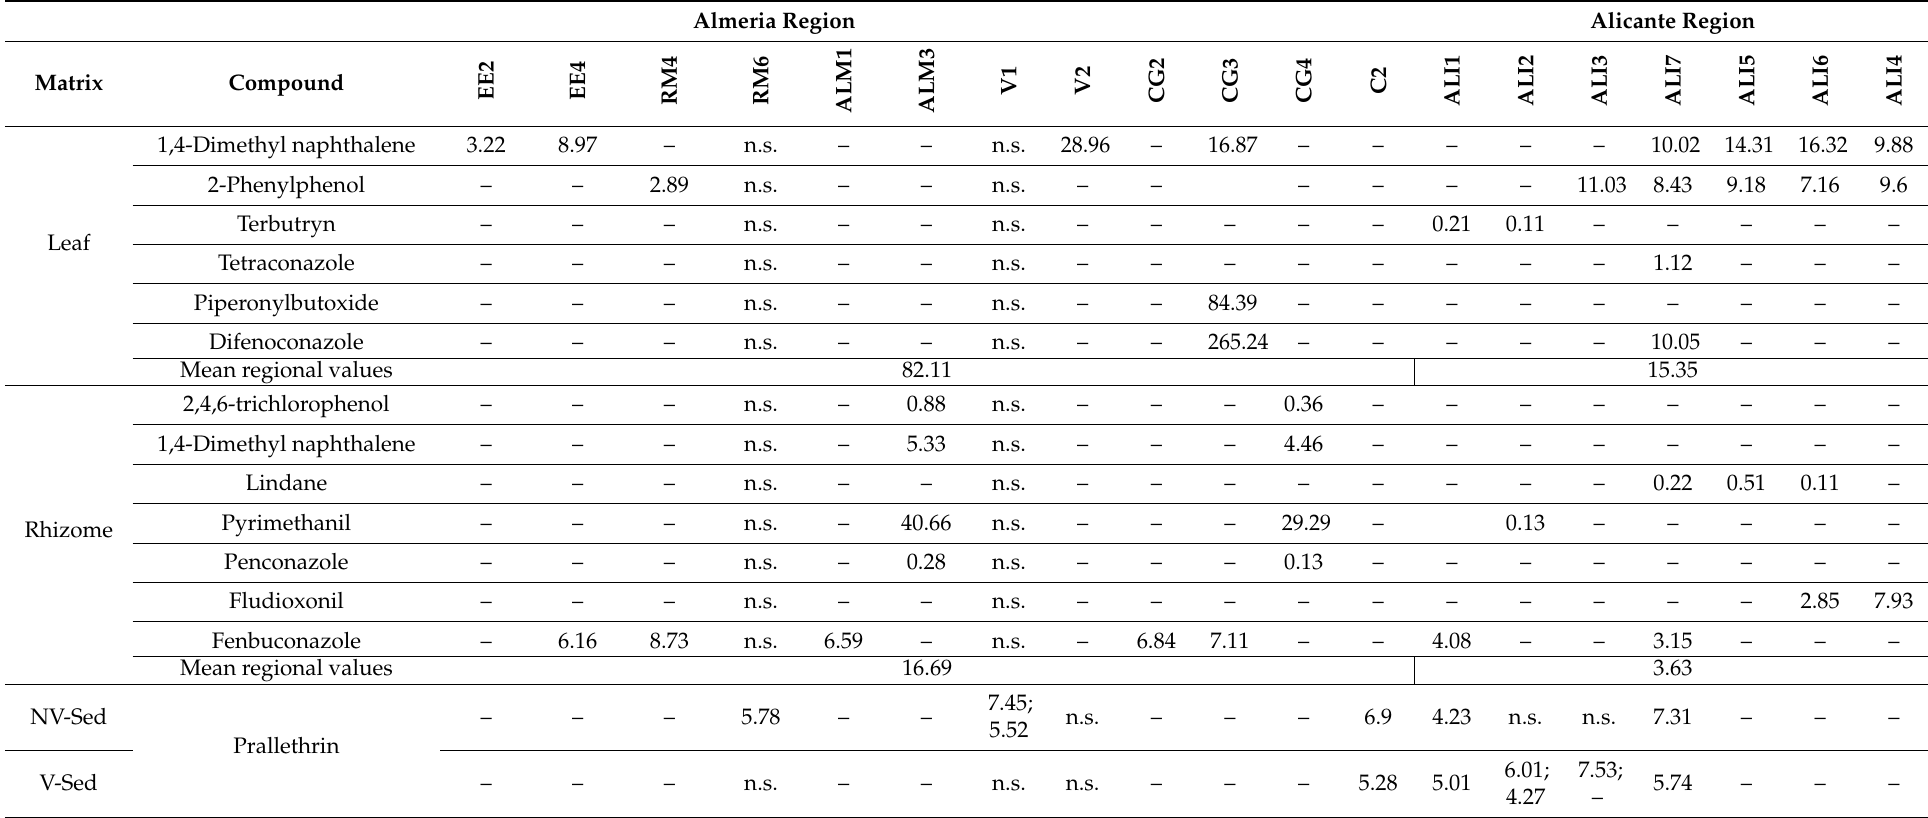
Table 4. Current-use pesticides ( µ g kg − 1 d.w.) identified in this study in P. oceanica , non-vegetated sediments (NV-sed) and vegetated sediments